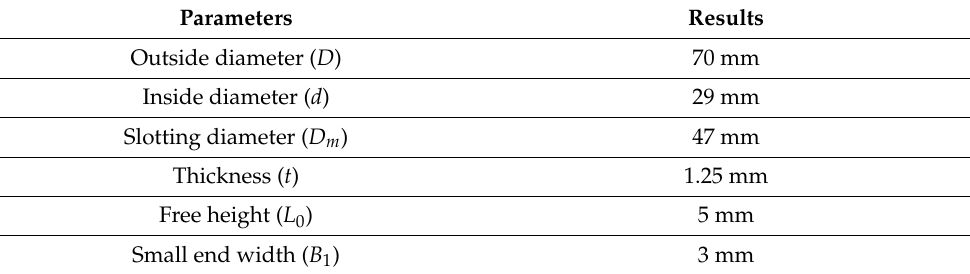
Table 2. Design results of main parameters of the slotted disc spring.